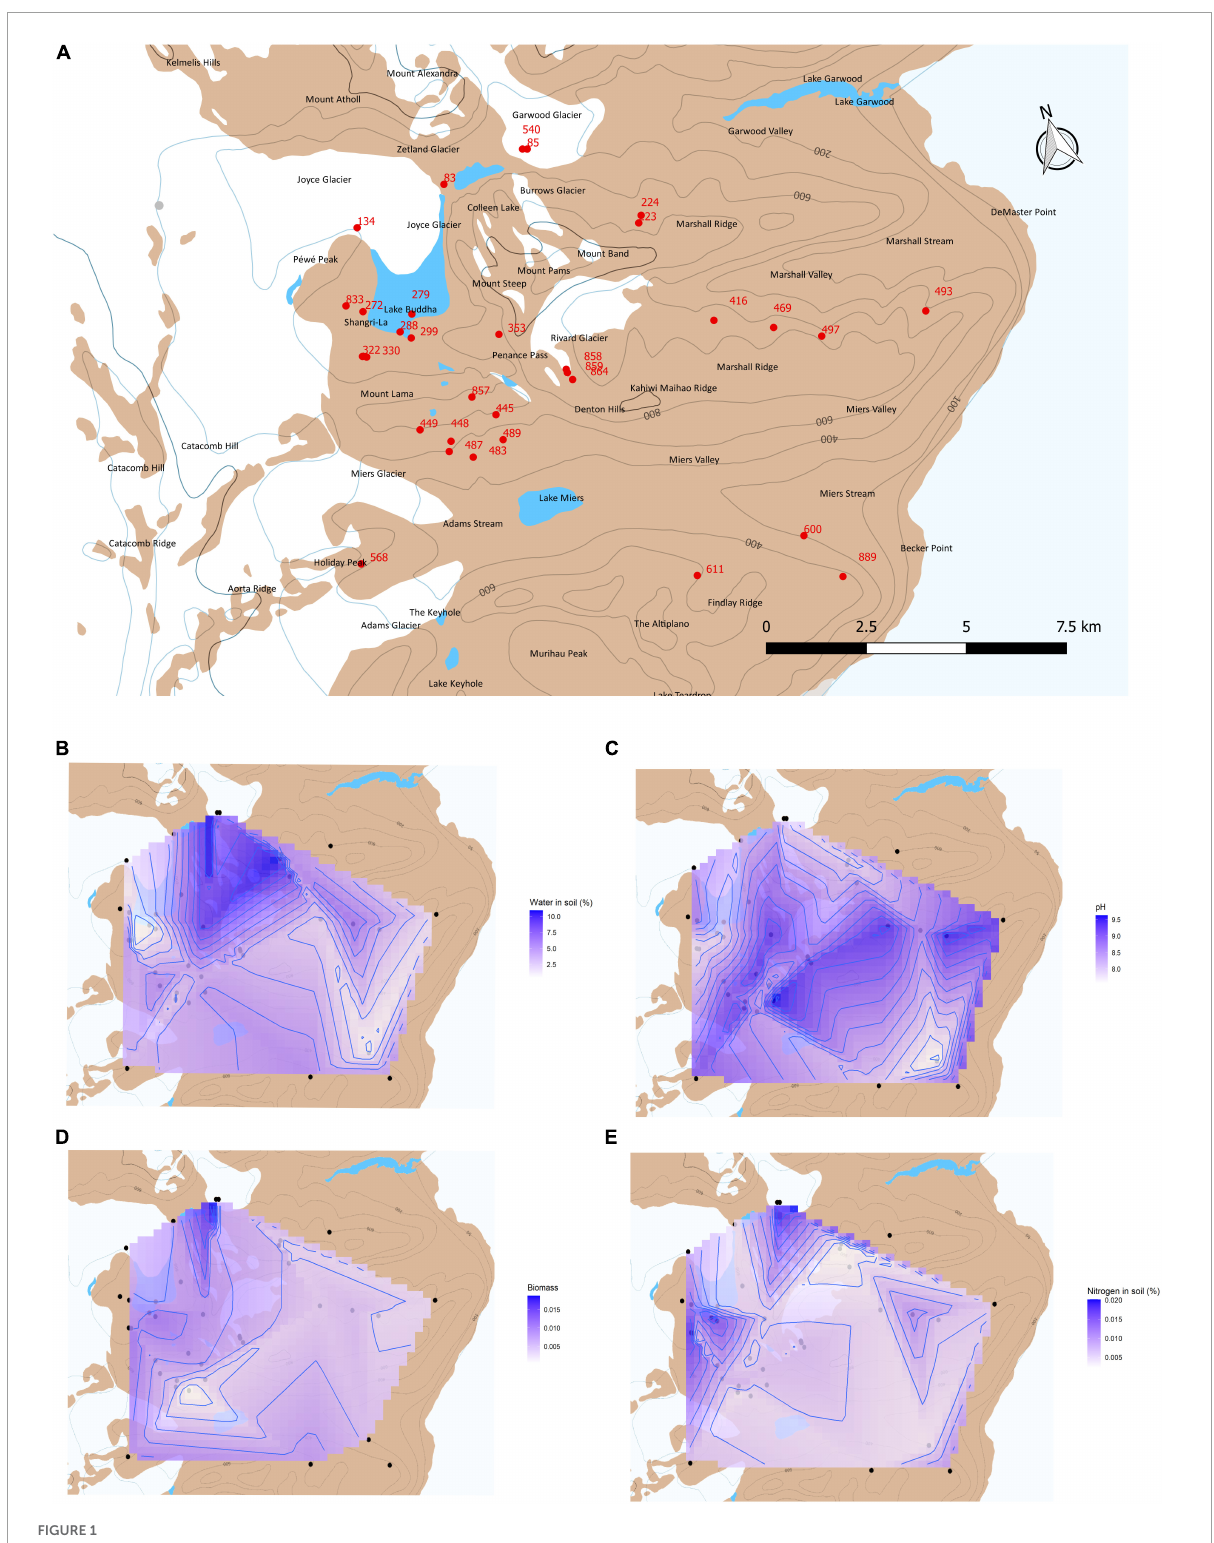
FIGURE1 (A) Map with selected sampling sites (red dots) of the MDV soils used for metagenomic analyses and respective unique codes. Blue denotes lake and white denotes glacier areas. Additional maps include linear interpolation in the area between samples for (B) percentage of water in soil, (C) pH, (D) biomass, and (E) percentage of